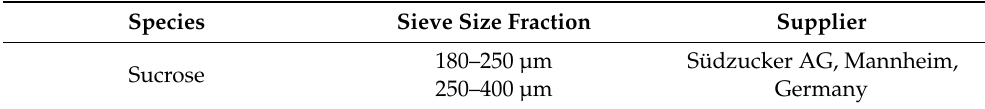
Table 3. Evaluated particle species and sieve size